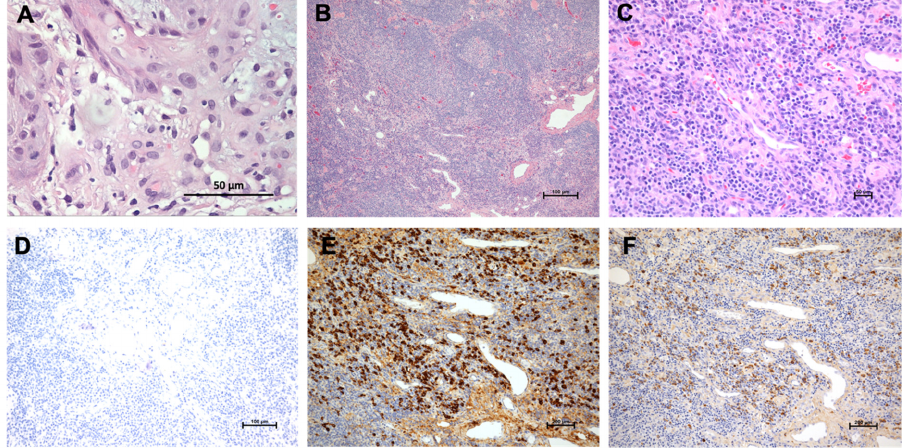
Figure 2. Histopathological examination. ( A ) SCC with invasive nests of large, keratinizing epider- moid cells is shown (HE × 400). The malignancy nature was identified by peer slide review; ( B ) the “onion-skin”-like layer of lymphocytes surrounding the hyperplastic germinal center (HE × 40); ( C ) prominent sheets of plasma cell proliferation in the interfollicular zone (HE × 200); ( D ) no HHV8- positive cells were detected to exclude HHV8-MCD (IHC × 100); and no kappa ( E ) (IHC × 100) and lambda ( F ) (IHC × 100) restriction shown to exclude plasma myeloma